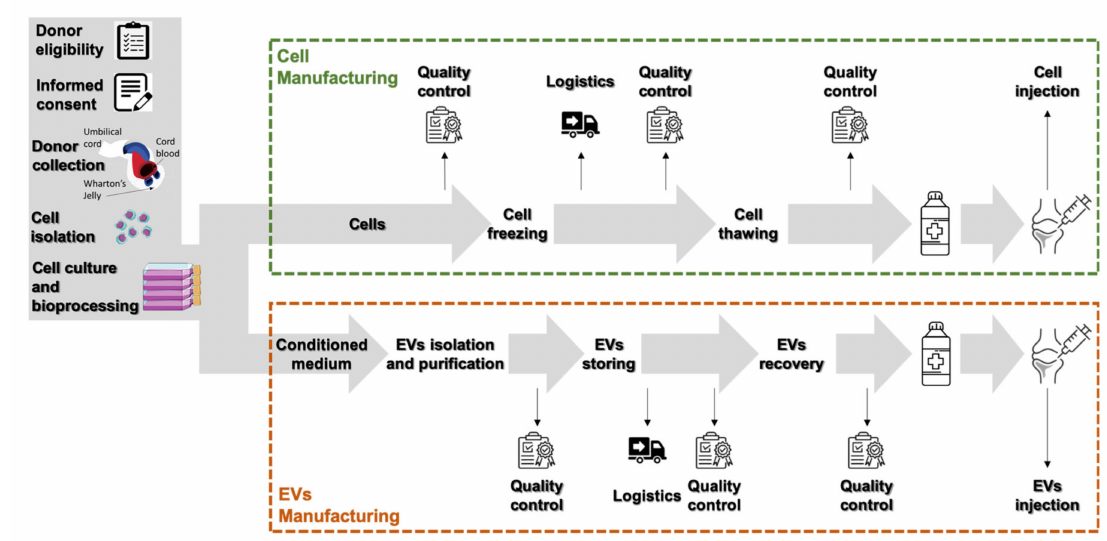
Figure 2. Manufacturing process for umbilical cord-derived MSCs and their